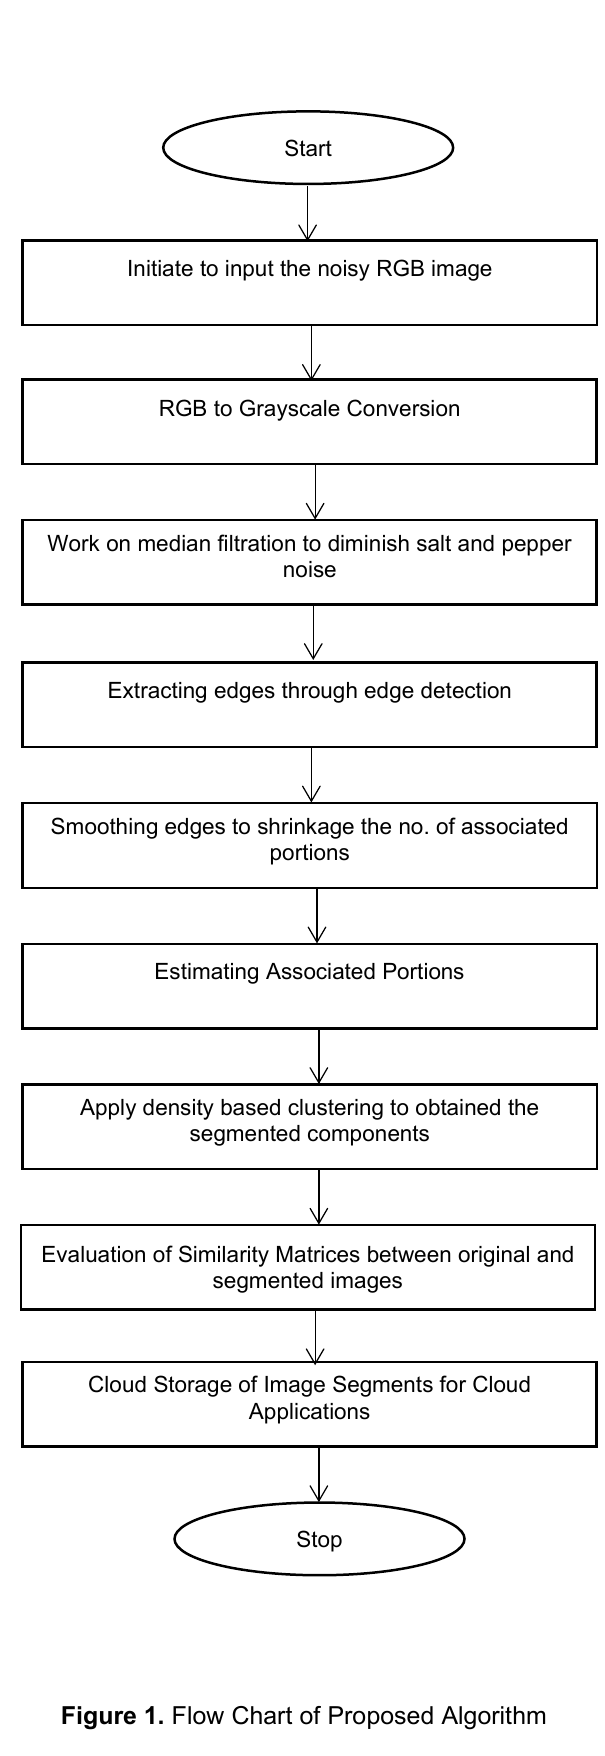
Figure 1. Flow Chart of Proposed